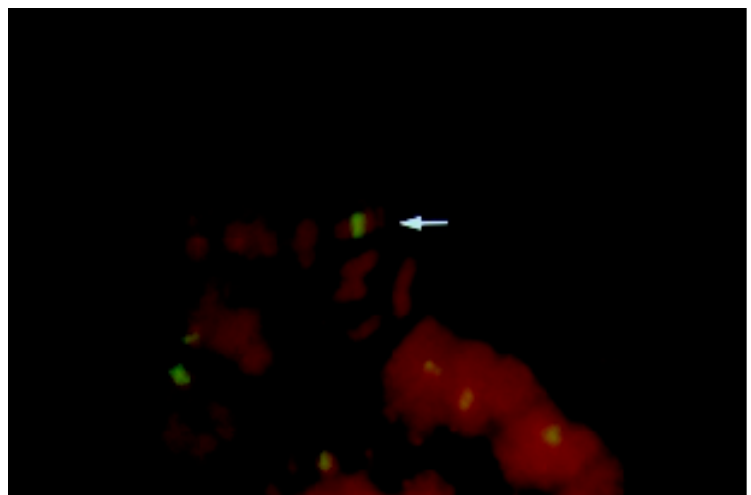
Figure 7 - FISH of Pattonella intermutans chromosomes us- ing a Drosophila rDNA probe. White arrow indicates the FISH signal in pair IV. The hybridization signal is yellow, whereas the chromosomes and nuclei are counterstained with propi- dium iodide